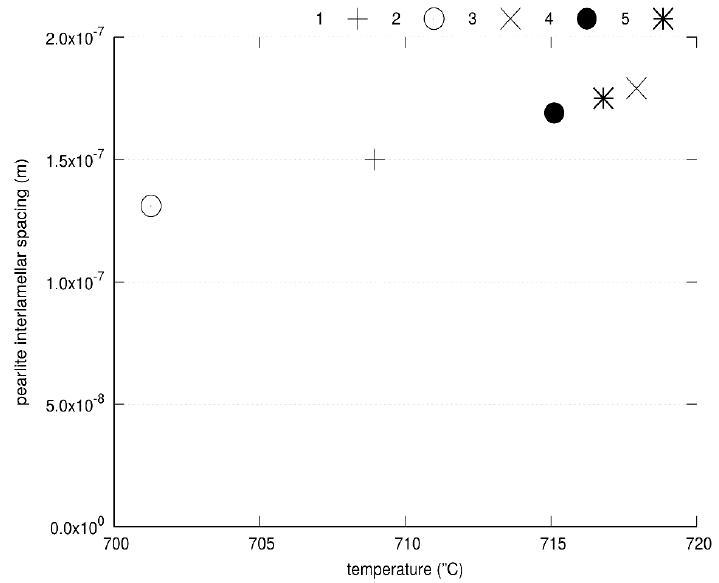
Figure 10. Simulated interlamellar spacing at the end of the metastable transformation at each of the five regions.